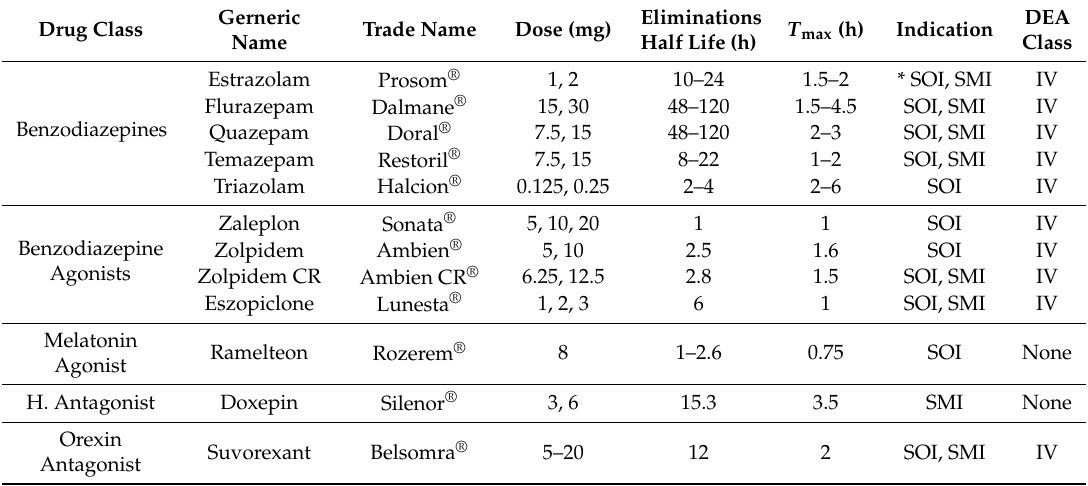
Table 1. The Food and Drug Administration (FDA) approved hypnotics for insomnia.